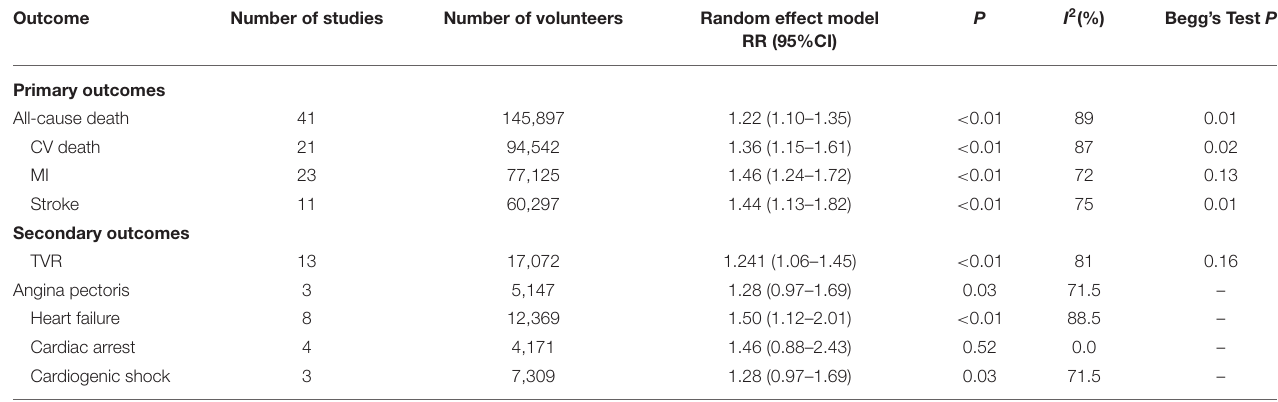
TABLE 2 | The main results of